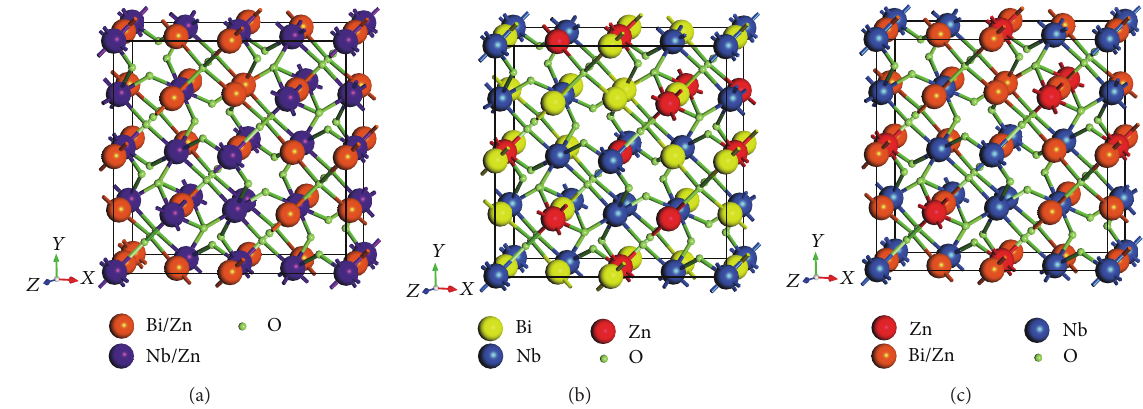
Figure 1: BZN structures viewed along the ⟨100⟩ direction, assuming (a) random, (b) ordered, and (c) partially ordered solid solutions. Bi, Nb, Zn, and O atoms are yellow, blue, red, and green balls, respectively. Rules for color mixing are used to represent sites with fractional occupancy; therefore, Bi/Zn and Nb/Zn sites become orange (yellow + red) and purple (blue + red),